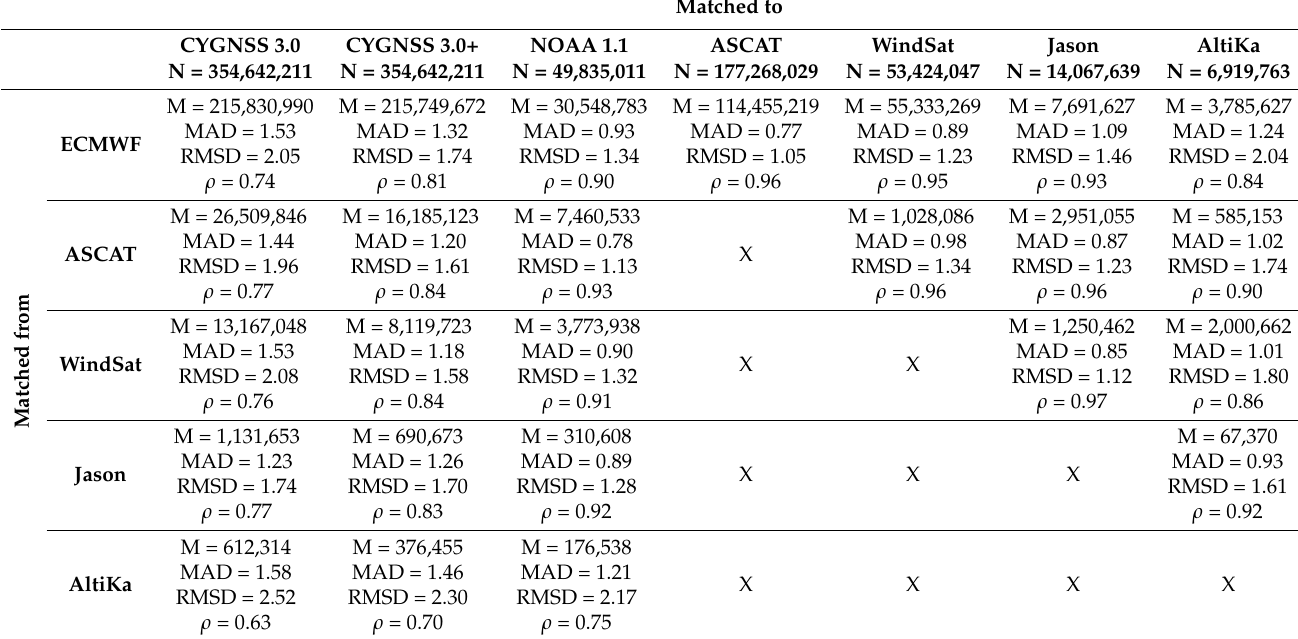
Table 3. Wind speed performance metrics between different sensors and ECMWF, and among the sensors. The wind speed products from the rows are collocated to the coordinates of the products from the columns. N is the total number of observations of a given product and M is the number of matched observations. ASCAT refers to the combined results from ASCAT-A and ASCAT-B (i.e., not to the results using a triple collocation). Similary, Jason refers to the combined results from Jason-2 and